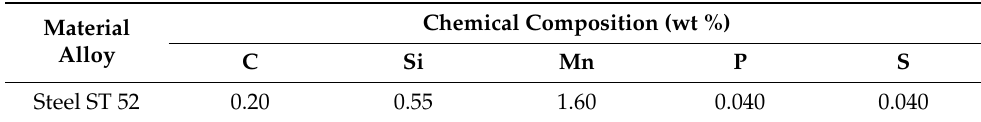
Table 1. Nominal composition of the material.